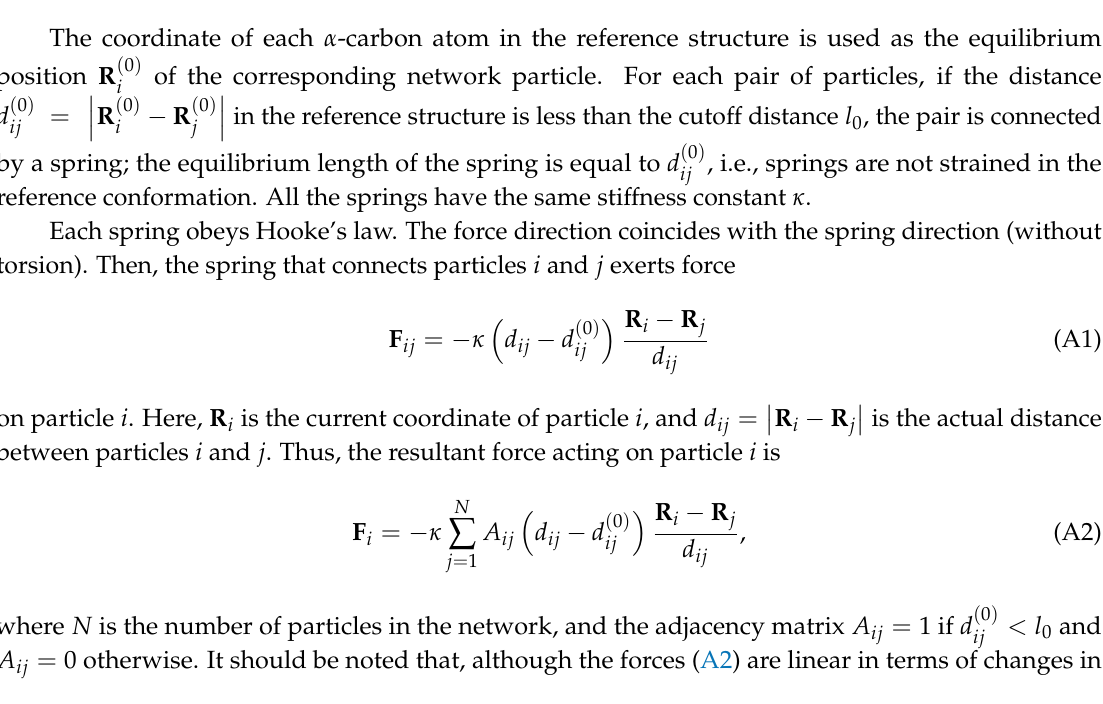
Figure A1. An illustrative example of the nonlinearity. Two springs are initially aligned straight without strains; each spring obeys Hooke’s law (equilibrium length: l 0 ) . If we pull the midpoint perpendicularly to the initial spring direction, the strength F of the resultant force F depends nonlinearly on the displacement x . Adapted from